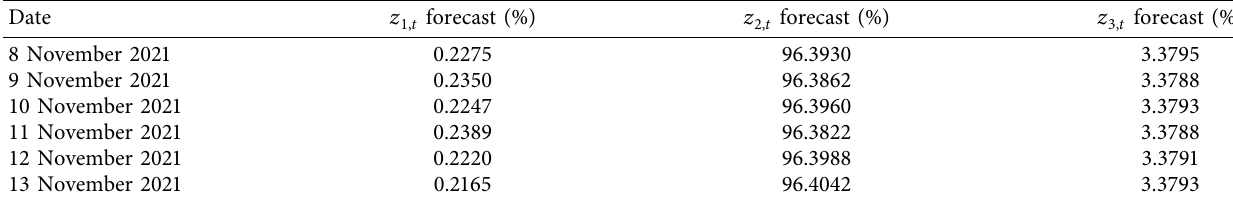
and z forecast (a) and z 1 ,t 1 ,t , z , and z forecasting 1 ,t 2 ,t 3 ,t